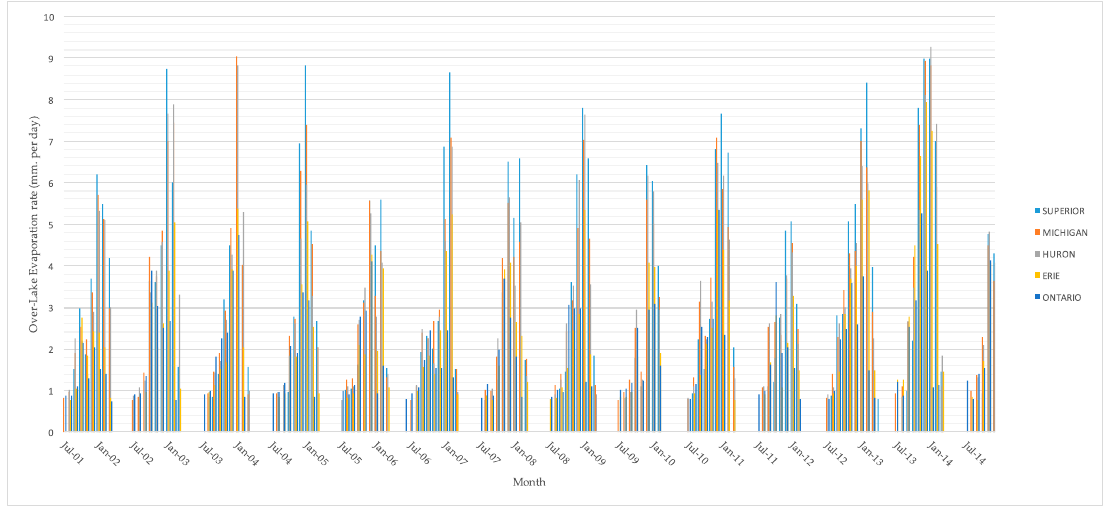
Figure 4. Long-term trend of monthly mean over-lake evaporation rate each of the Great Lakes observed from July 2001 to December 2014.